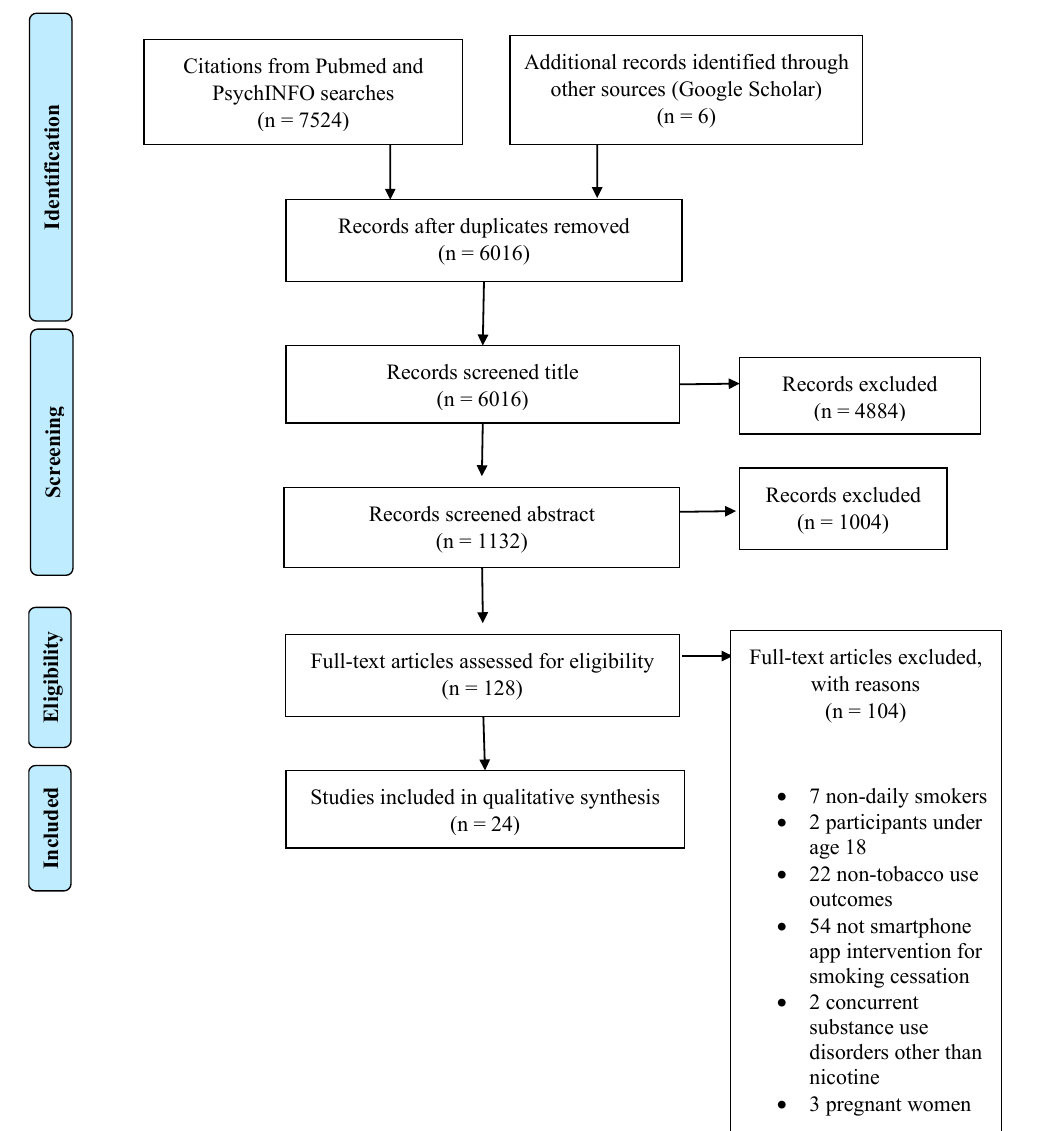
Figure 1. PRISMA flowchart.